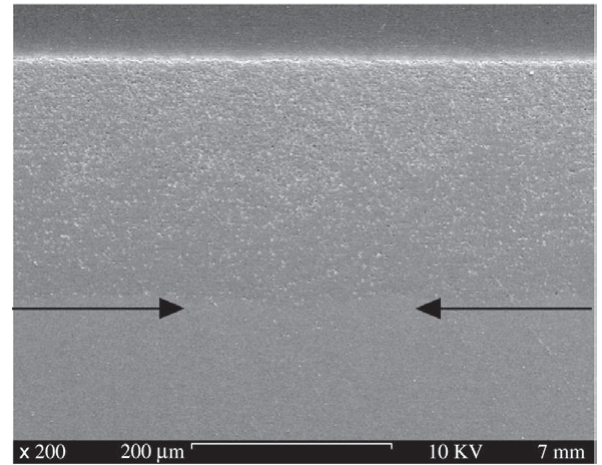
Figure 5. Cross section of Si H SO at 90°C as observed by REM. The arrows mark the change 2 4 from the porous corroded zone to base